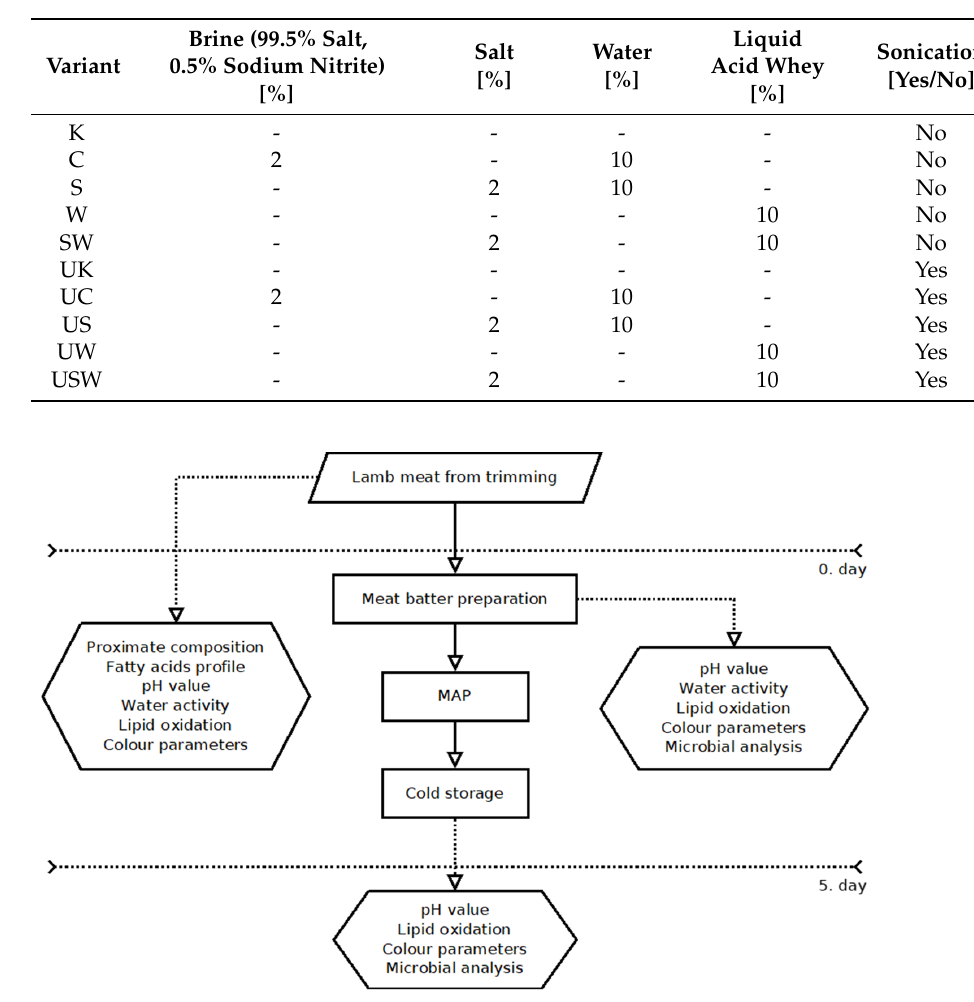
Figure 1. Stuffing preparation and testing scheme.